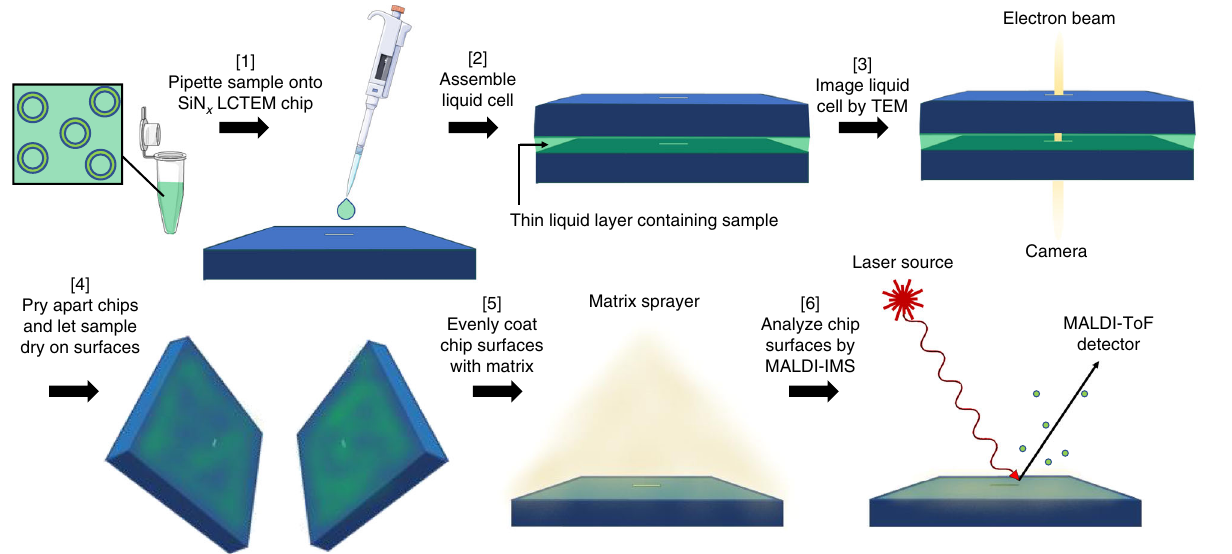
Fig. 3 Overview of the work fl ow: LCTEM combined with MALDI-IMS post-mortem analysis. (1) The sample of interest is pipetted onto a bottom SiN x LCTEM chip, and then (2) another LCTEM chip is placed on top and hermetically sealed. Next, (3) the assembled liquid cell is placed in a TEM for imaging. After imaging, (4) the chips are gently pried apart by hand and the sample is allowed to dry on chip surfaces. (5) Chip surfaces are evenly sprayed with matrix, and then (6) analyzed by MALDI-IMS. This fi gure was produced using Servier Medical